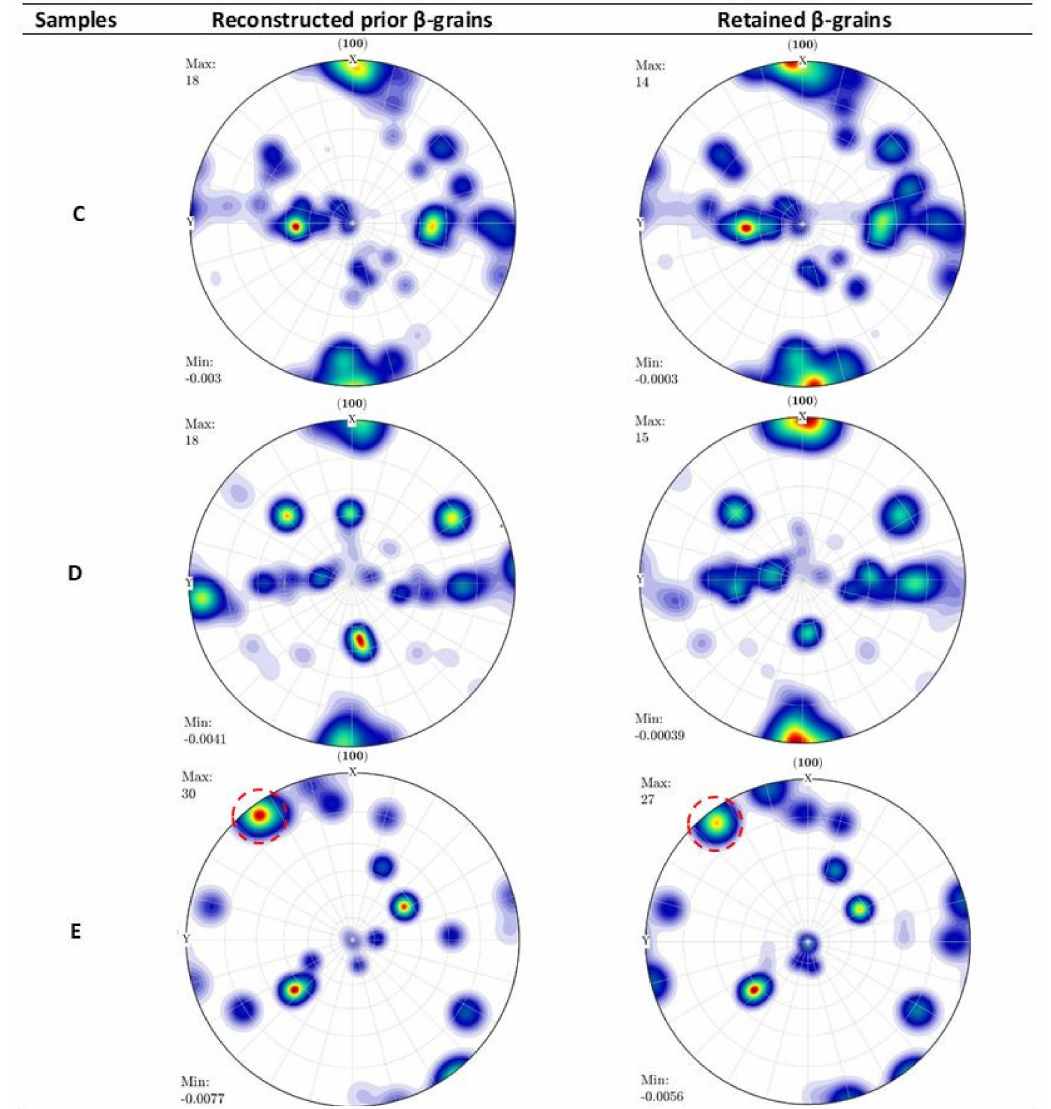
Figure 6. The (100) plane contour pole figures of the reconstructed prior β -grains and retained β -grains in samples (C, D,